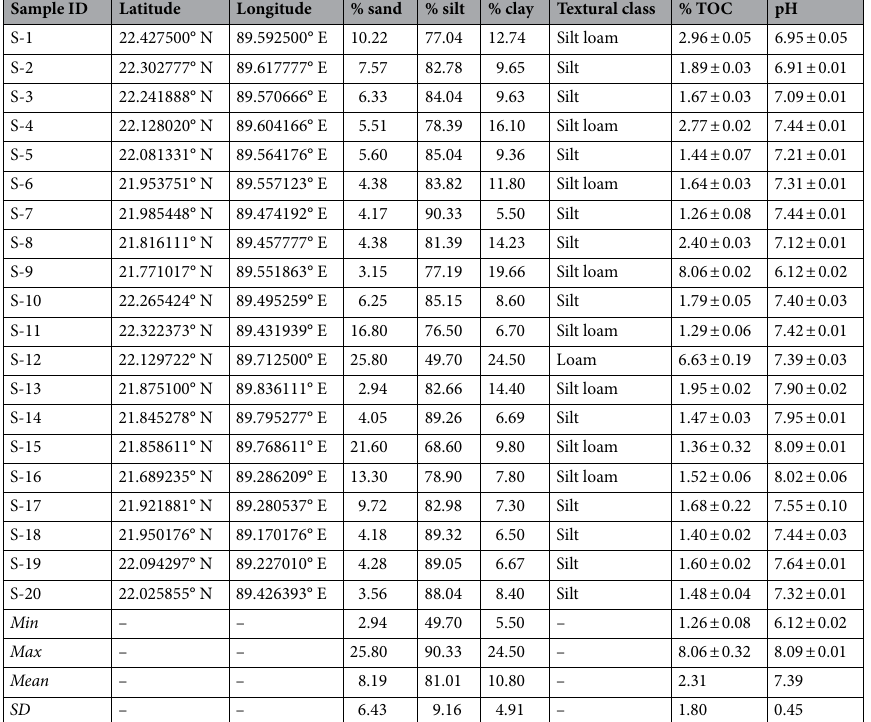
Table 3. Soil physical and chemical properties of the Sundarbans mangrove. Min. minimum, Max maximum, SD standard